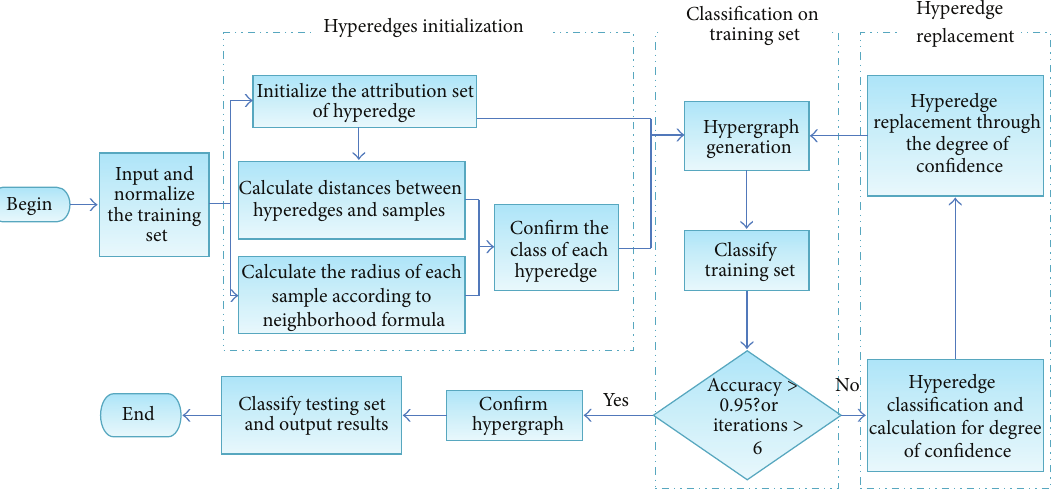
Figure 4: The flow chart of algorithm.